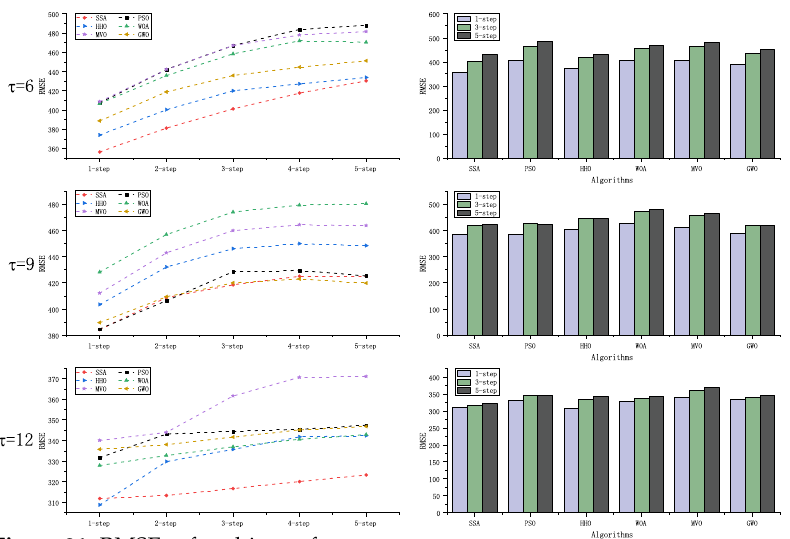
Figure 21. RMSEs of multi-step forecasts.